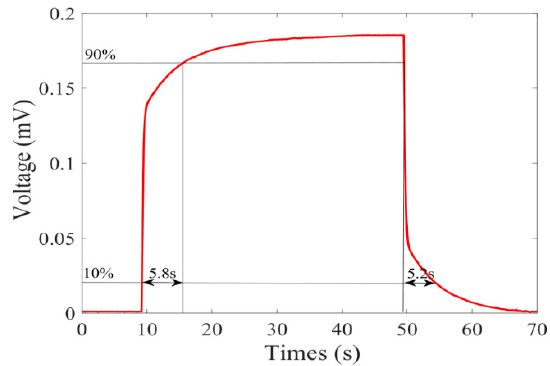
Figure 7. Continuous measurement result of 1000 ppm CH 4 .